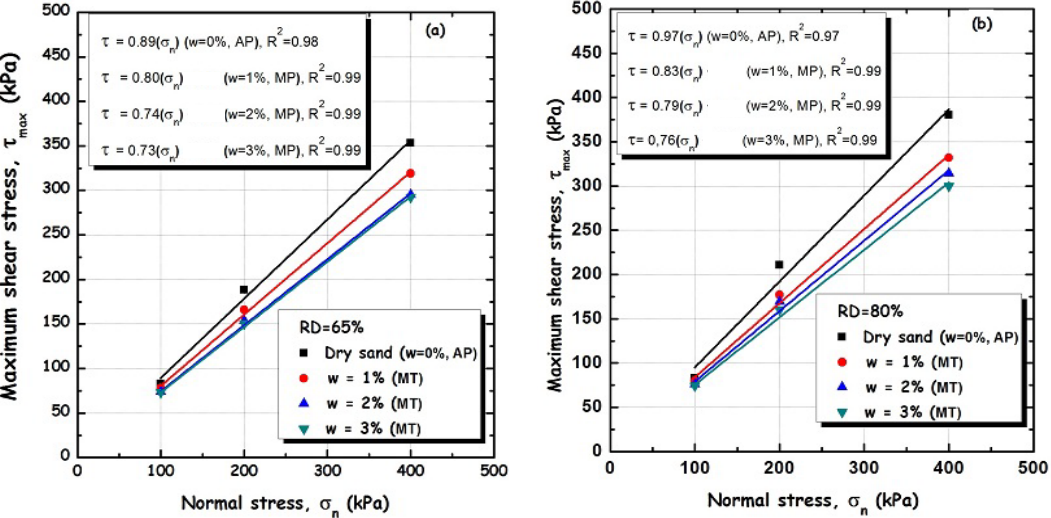
Figure 14: Effect of water content on the mechanical behaviour of clean sand: Maximum shear stress versus normal